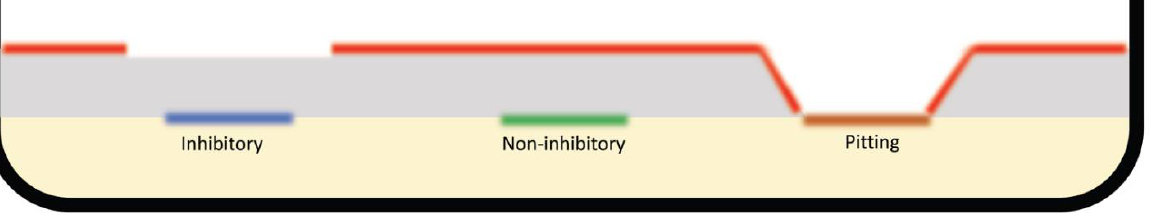
Figure 1. Agar overlay assay testing the ability of various bacterial species to inhibit the growth of a lawn of N. gonorrhoeae strain RL1 ( a ) and strain 21.189 ( b ). Only the colonies of Escherichia coli (Ec) and Streptococcus pneumoniae (Sp) inhibited the growth. The colonies of N. mucosa in ( c , d ) did not exhibit any inhibitory effect on the growth of N. gonorrhoeae strain 21.163 ( c ) and strain WHO-W ( d ). A close-up of one of the N. mucosa colonies in ( d ) demonstrates the pitting ( p ) of the upper layer of agar around the right-hand colony of N. mucosa . Ec — Escherichia coli (ATCC 25922); Lc — Lactobacillus crispatus (LMG 9479); p — pitting; Sa — Staphylococcus aureus (1:ATCC 29213, 2:ATCC 25913); Sp — Streptococcus pneumoniae ( ATCC 49619 ) ; Spy — Streptococcus pyogenes (LMG 14238).